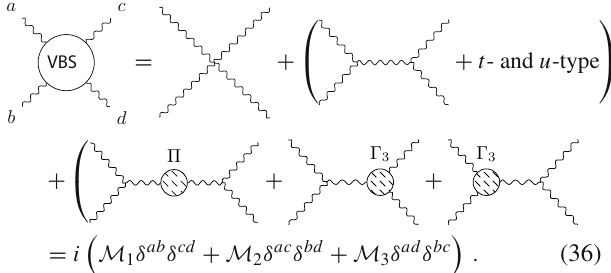
of a fermion (scalar) multiplet. The colored bands, based on the results of Ref. [48], provide an estimate of present experimental sensitivity at the 1 σ and 2 σ